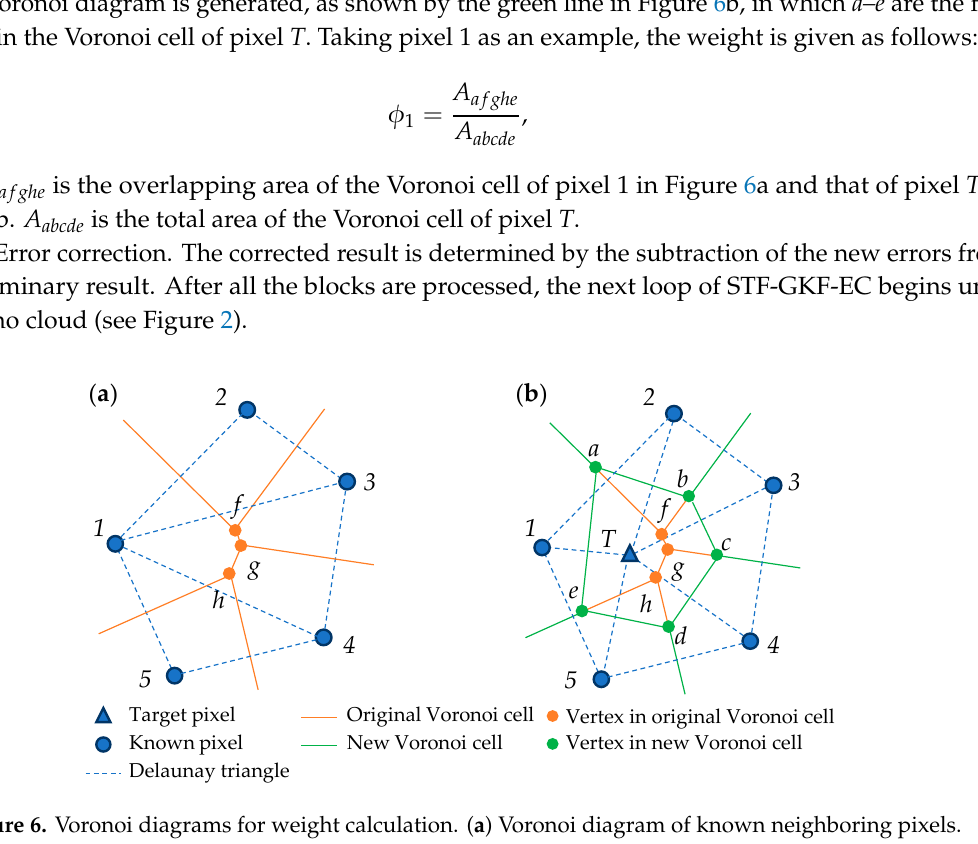
Table 1. Description of the confusion matrix and definition of the validation metrics. Truth \